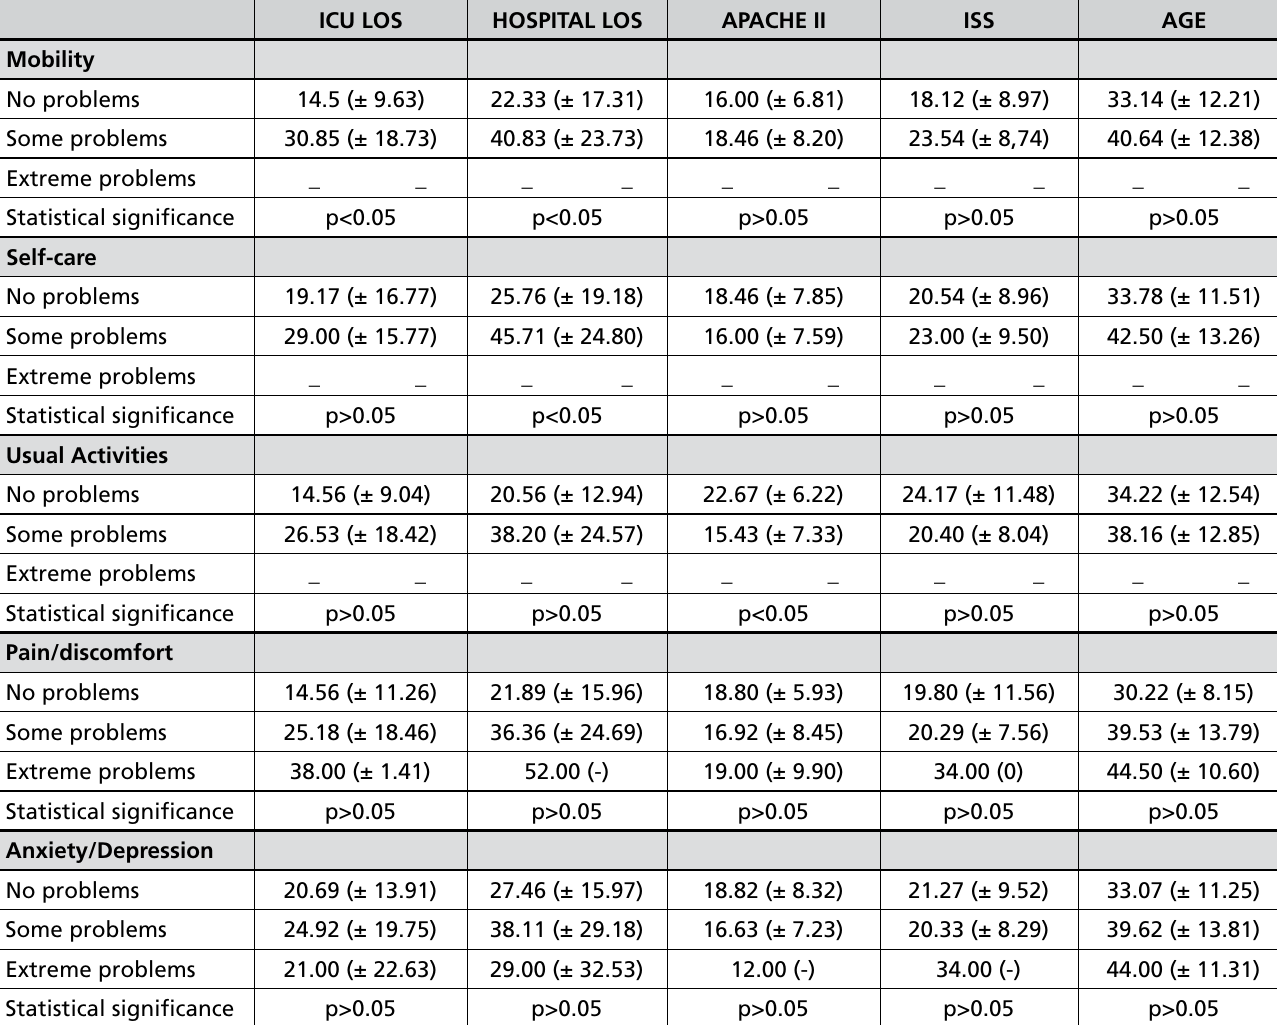
table iV: comparison between eQ-5D items and the various outcome measures